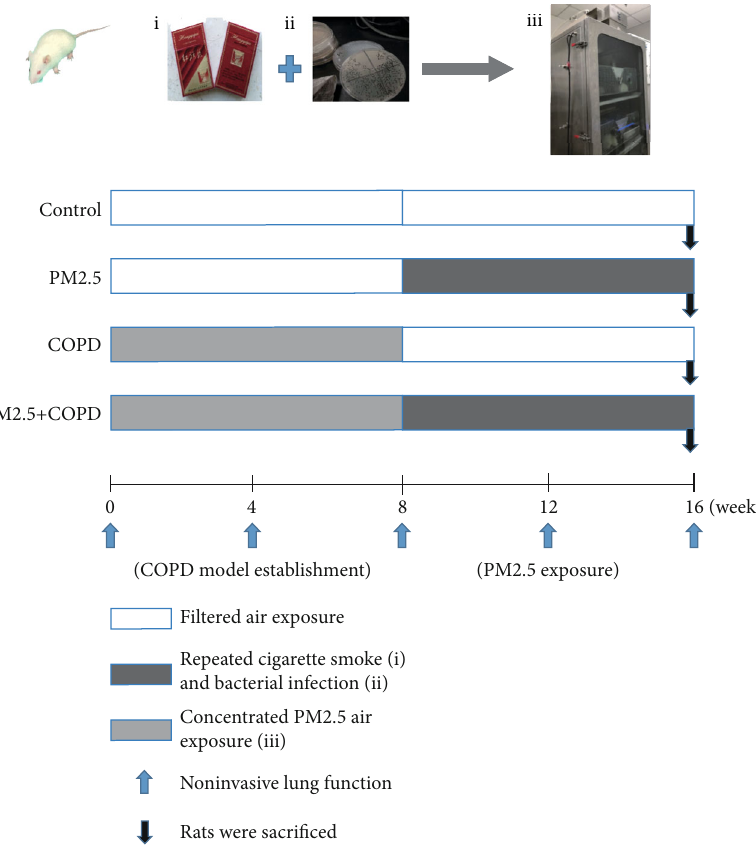
Figure 1: Experimental protocol. SD rats were divided into control, PM2.5, COPD, and PM2.5+COPD groups. During weeks 0 ~ 8, for the COPD and PM2.5+COPD groups, the COPD rat model was prepared by using repeated cigarette smoke inhalation and bacterial infection. During weeks 8 ~ 16, rats in the PM2.5 and PM2.5+COPD groups were exposed to concentrated PM2.5 atmosphere in the whole-body exposure chamber, 4 hours per day. Rats in the control group were exposed to fi ltered air all the time. At weeks 0, 4, 8, 12, and 16, the noninvasive lung function (TV, PEF, and EF50) were measured. All rats were sacri fi ced within 24 h of the last PM2.5 exposure. And lung function, pulmonary histopathology, in fl ammatory cytokines, oxidative stress, mucus secretion, and proteinases/antiproteinases were detected. Control: healthy rats; PM2.5: particulate matter 2.5 treatment alone rats; COPD: chronic obstructive pulmonary disease rats; PM2.5+COPD: COPD rats exposed to prolonged PM2.5 for 8 weeks. TV: tidal volume; PEF: peak expiratory fl ow; EF50: expiratory fl ow